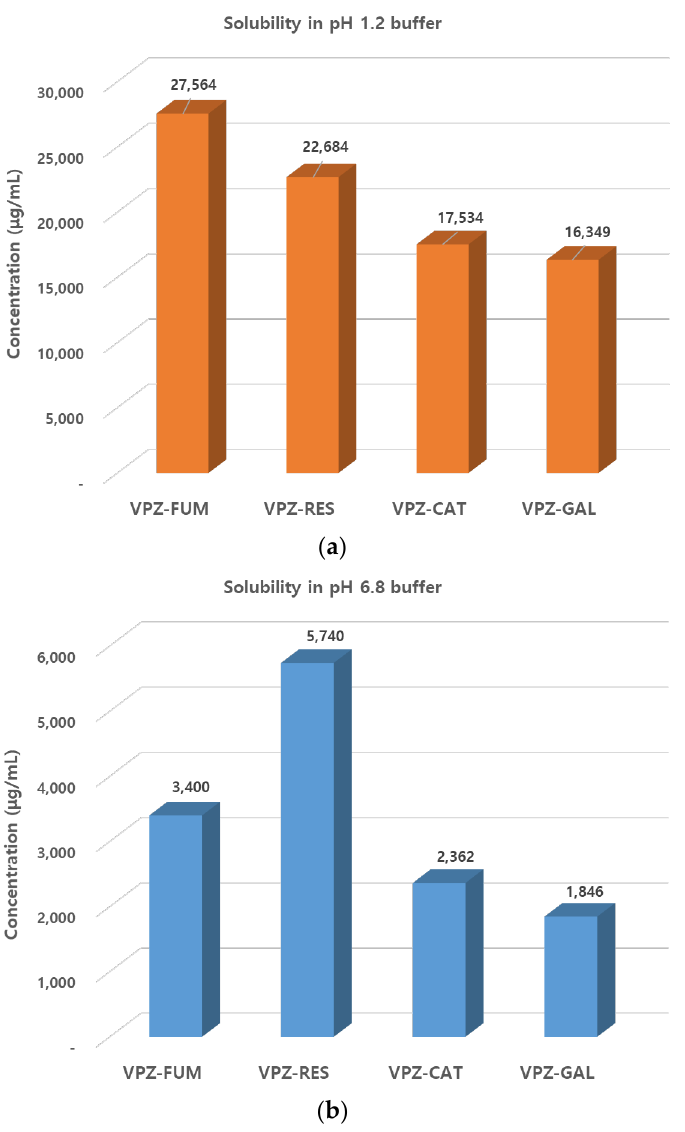
Figure 7. Comparative solubility of VPZ cocrystals and VPZ fumarate in ( a ) pH 1.2 and ( b ) pH 6.8 buffer solution. Table 3. Solubility and dissolution rate of VPZ cocrystals and VPZ fumarate.